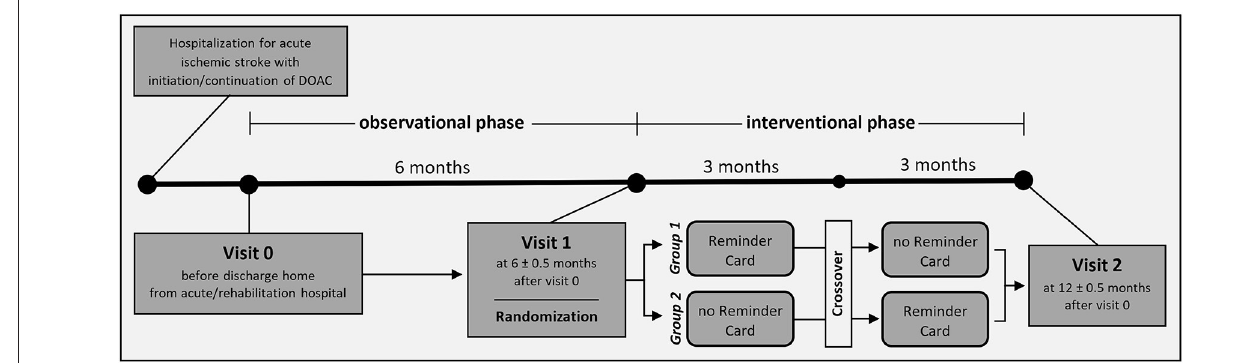
FIGURE 1 | Study flowchart.